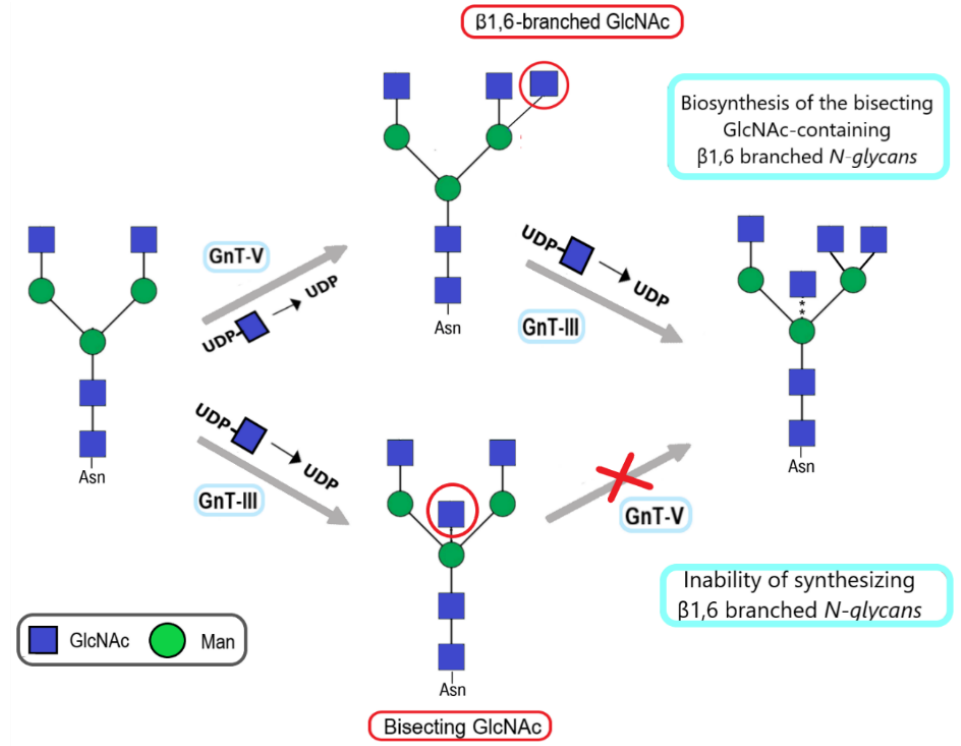
Figure 3. GnT- V catalyzes the formation of β1,6 branched complex type N-glycans. GnT-III